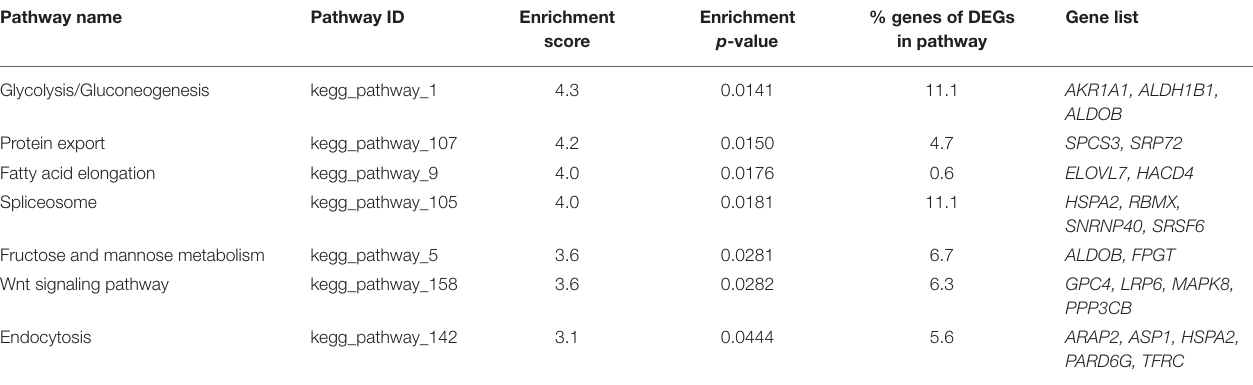
TABLE 4 | Enrichment analysis of pathways for down-regulated differentially expressed genes in vitrified